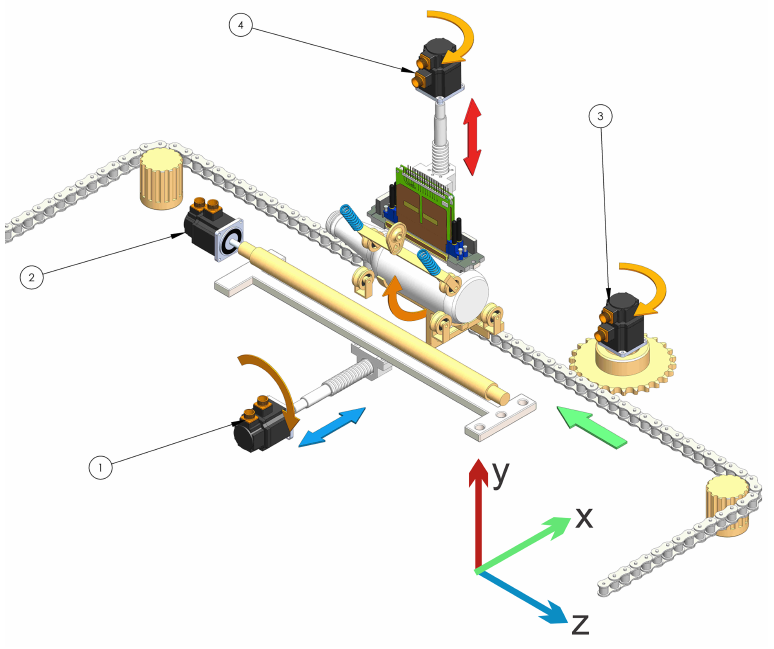
Figure 9. Scheme topology